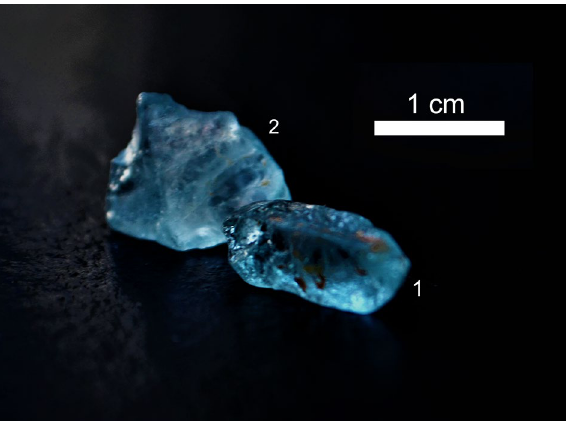
Figure 1. Topaz from Padre Paraíso municipality in Minas Gerais State in Brazil. Dimensions are 1 × 0.5 × 0.3 cm and 1 × 1.3 × 0.4 cm for crystal 1 and 2, respectively. They both are light blue in colour with good transparency and of medium–high clarity. Impurities (brownish-red area) were removed before chemical and structural analyses. The pic has been cropped with GIMP-GNU image manipulation program (https ://www. gimp.org/) and the scale has been added with a Microsoft Office